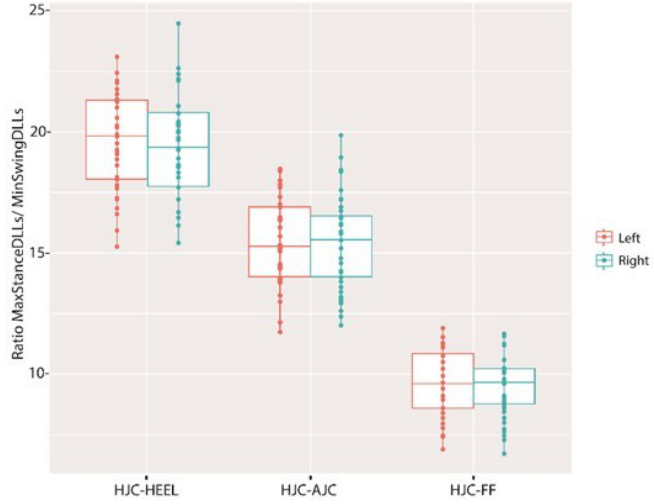
Figure 6. Ratio between maximal DLLs during the stance phase and minimal DLLs during the swing phase.